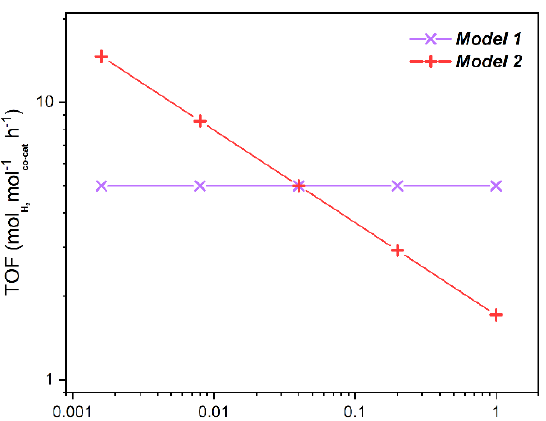
Figure A2. Double logarithmic representation of the TOF trends for Model 1 (purple constant) and Model 2 (red slope) for comparison with the catalytic performance of the series-prepared composite photocatalysts.